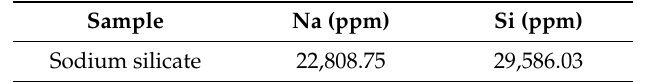
Table 2. Concentrations of Na and Si in the sodium silicate from the rice husk ash.